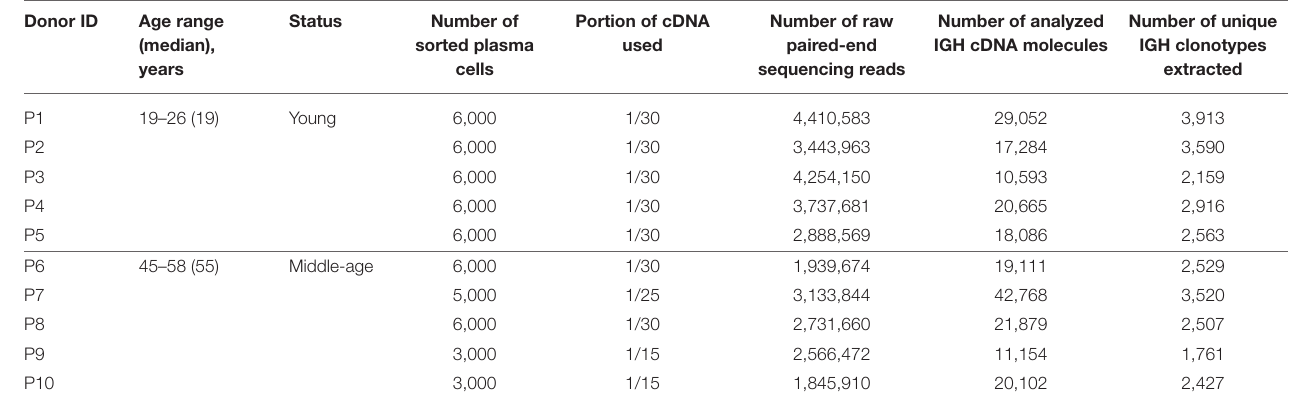
TABLE 1 | Donor and sample